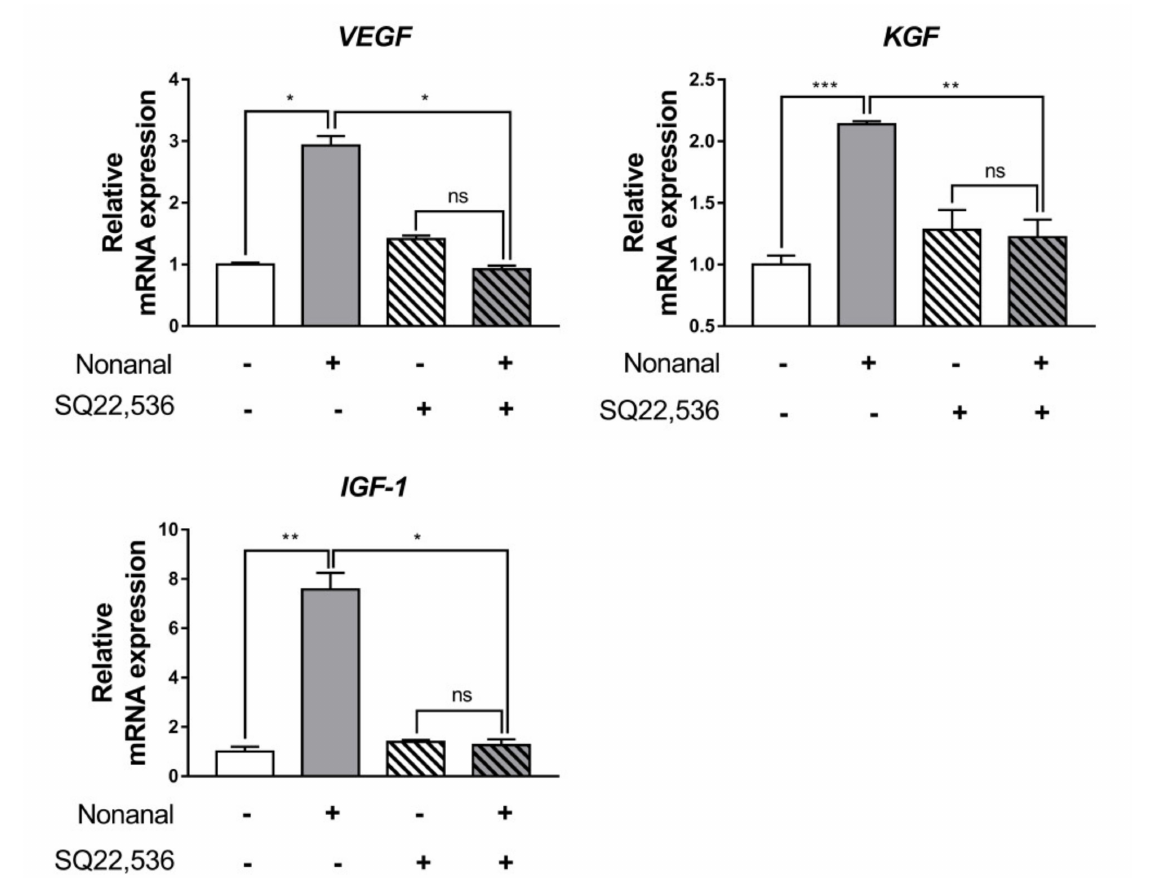
Figure 6. E ff ect of cAMP inhibitors on nonanal-stimulated mRNA expression of growth factors. DPCs were treated with vehicle or 50 µ M nonanal for 6 h. The vehicle or 50 µ M SQ22,536 was added 1 h before nonanal treatment. Relative mRNA levels of the growth factors were measured by real-time PCR. Data were statistically analyzed using the Student’s t -test. Data are presented as mean ± SEM of the results of three independent experiments. * p < 0.05, ** p < 0.01, *** p < 0.001. ns, not